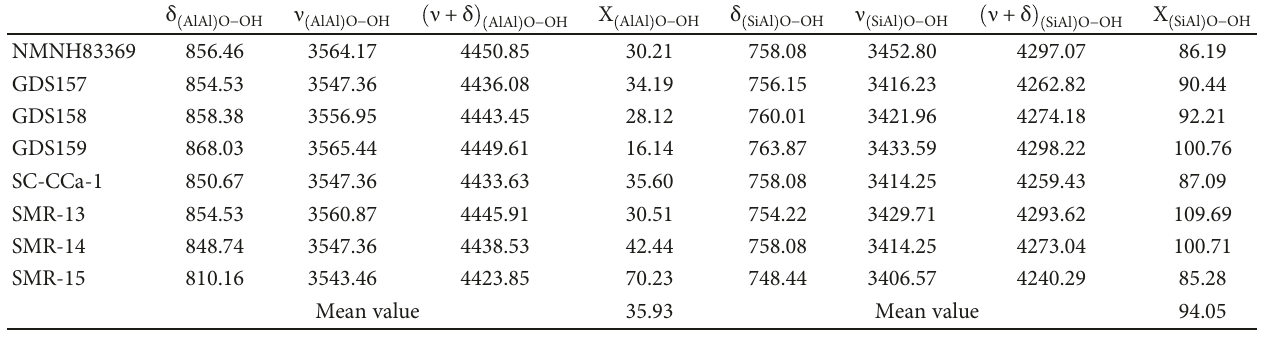
Table 4: Wavenumbers (in cm − 1 ) of the ν values of the anharmonicity constant X